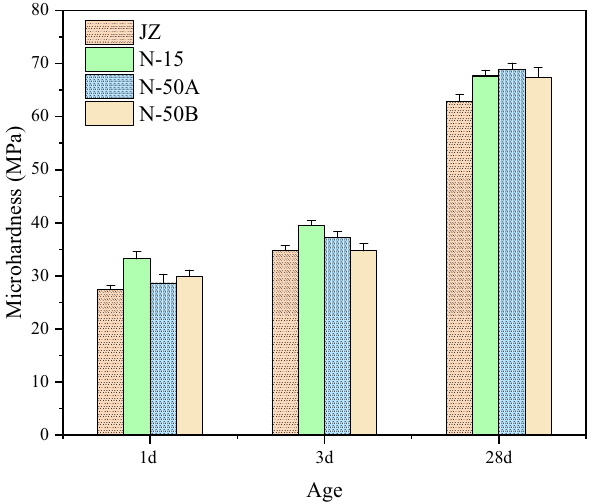
Figure 2: Interface microhardness of specimens.